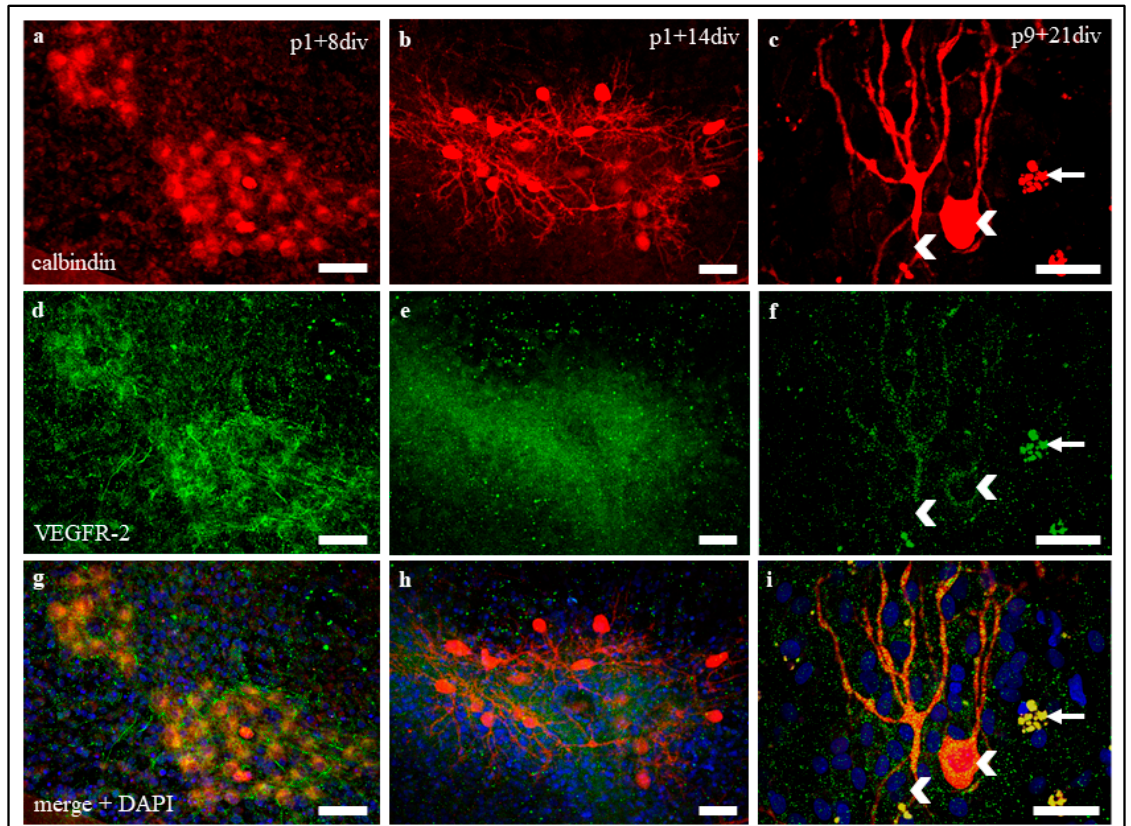
Figure 3. VEGFR-2 expression in organotypic slice cultures at p1 + 8 div, p1 + 14 div, and p9 + 21 div. ( a – i ) Immunostaining of calbindin positive PC (red), VEGFR-2 (green), and cell nuclei (blue) in organotypic cerebellar slice cultures at p1 + 8 div, p1 + 14 div, and p9 + 21 div. VEGFR-2 is detectable in PC soma and dendrites in all development stages. ( c , f , i ) Exemplary, two PC soma (white arrowheads) and some cell detritus (died PC, white arrows) are marked. The same exposure settings were used for all exposures and no post-correction was applied. Scale bars: 100 µ